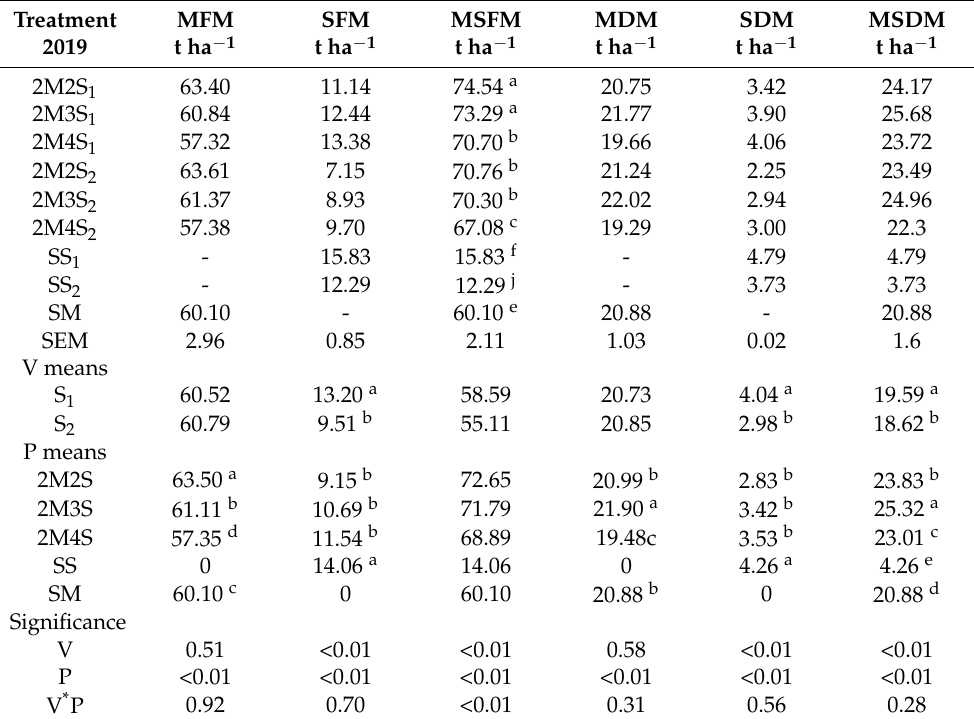
Table 2. Whole crop fresh and dry matter yield of maize and soybean as affected by different planting patterns in 2019.